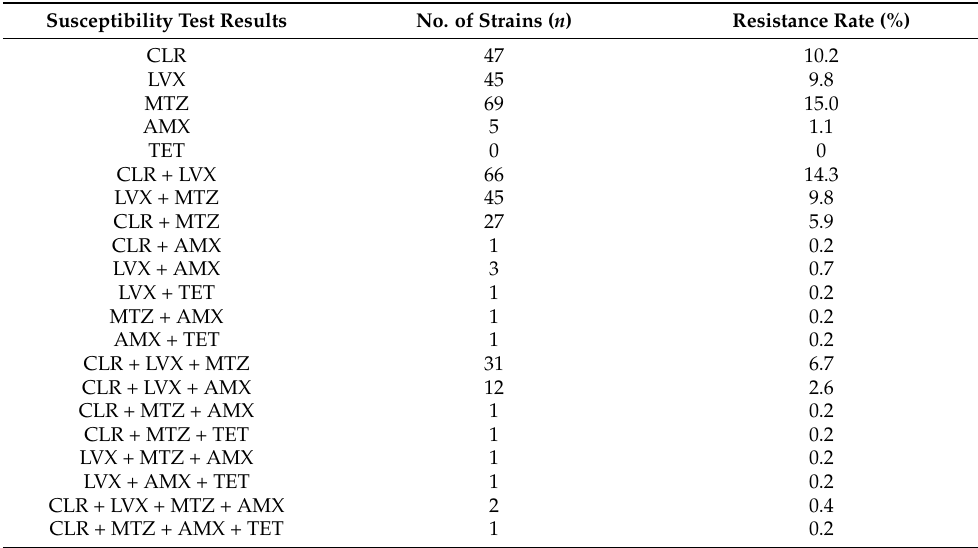
Table 4. Antibiotic resistance patterns of H. pylori strains (N =